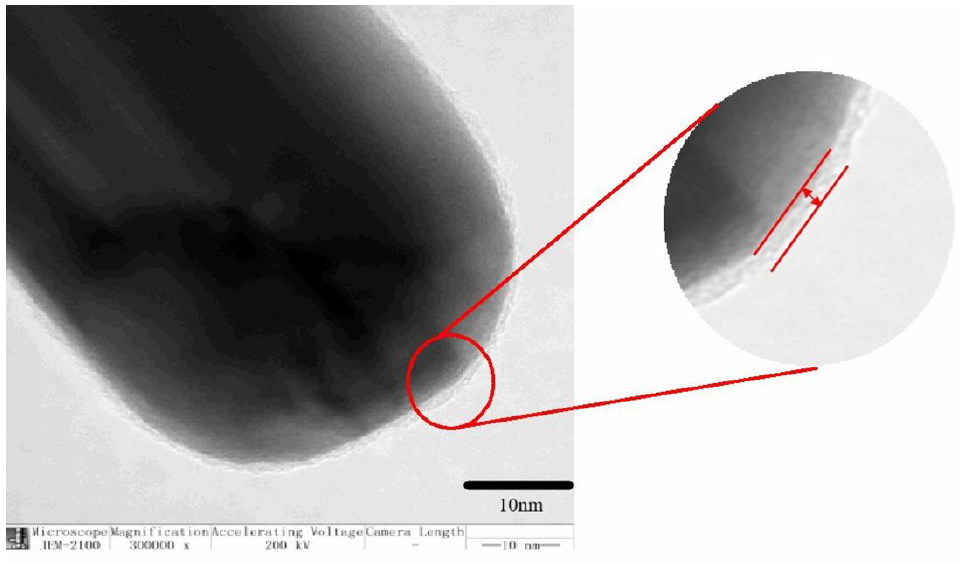
Figure 2. TEM of Ag nanowire coated by polydopamine.